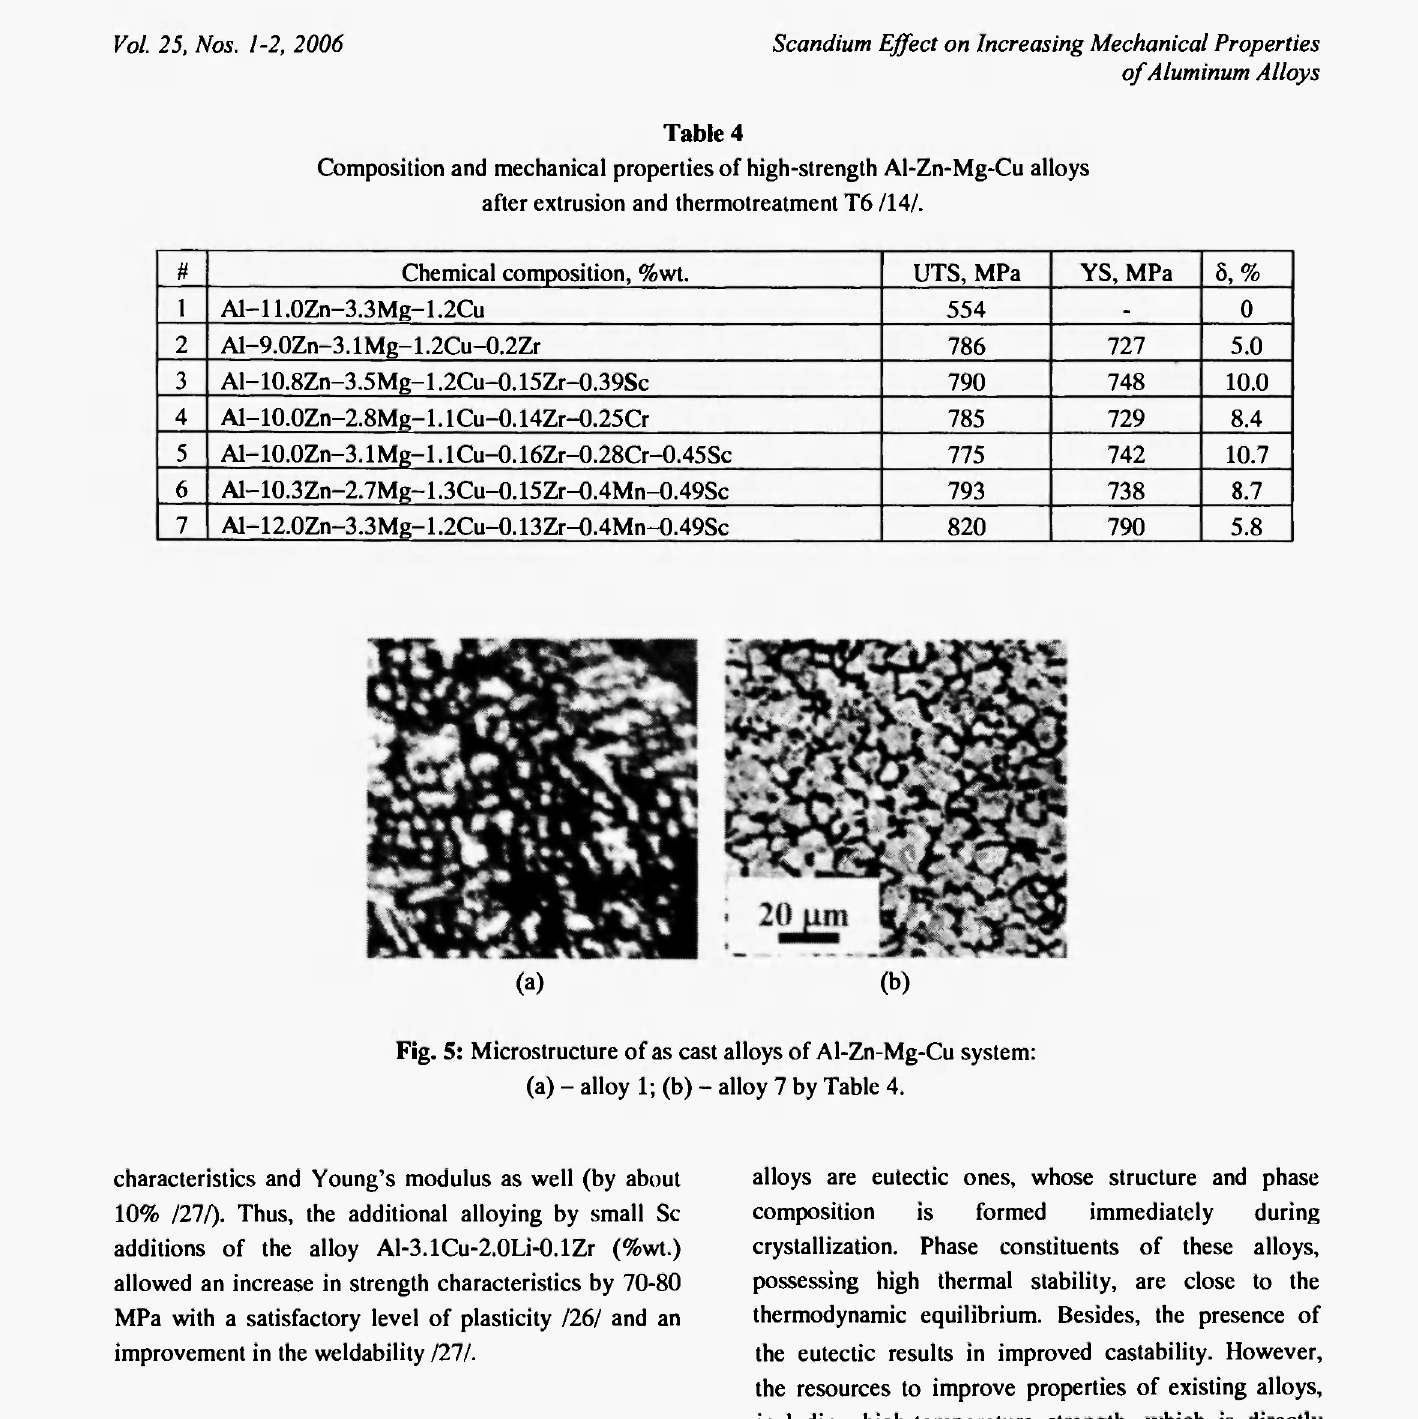
Fig. 5: Microstructure of as cast alloys of Al-Zn-Mg-Cu system: (a) - alloy 1; (b) - alloy 7 by Table